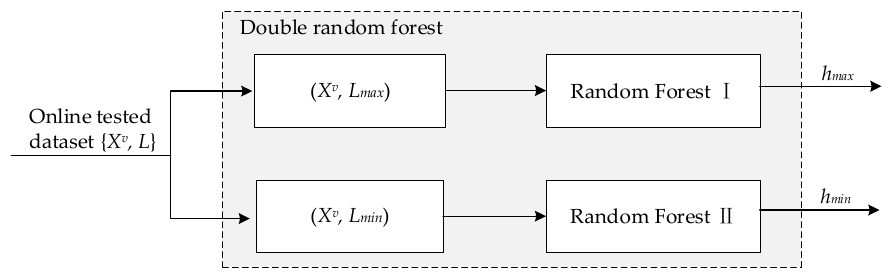
Figure 4. Schematic of the double random forest model for the vibration state.